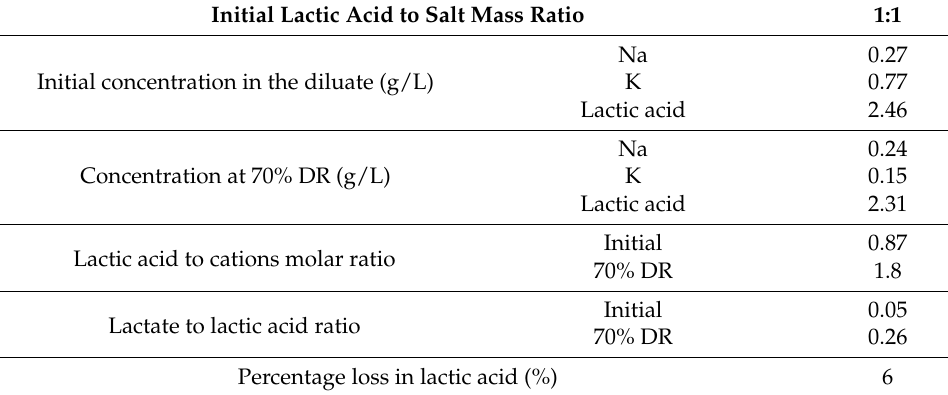
Table 3. Experimental results at 70% DR for a feed solution of lactic acid, KCl and NaCl. Initial Lactic Acid to Salt Mass